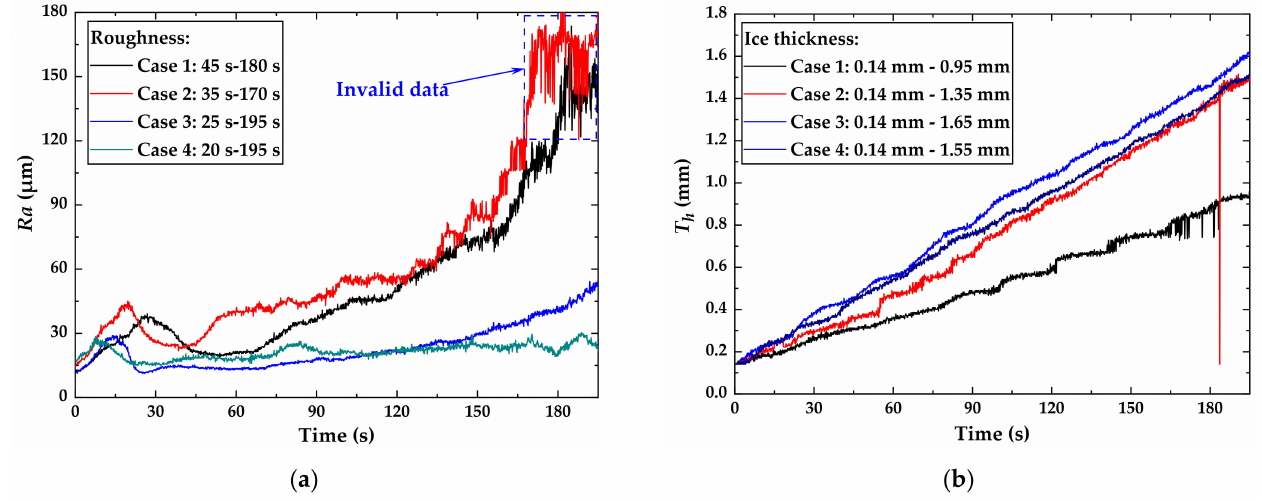
Figure 17. Experimental results from the icing research tunnel: ( a ) the growth process of the ice layer, and ( b ) the variation in surface roughness on the ice